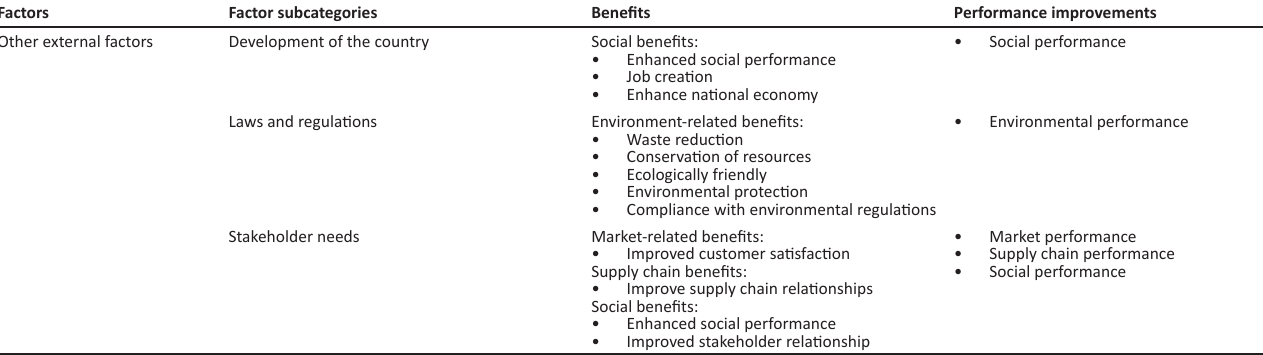
TABLE 4 (Continues...): Conceptual framework of the impact of disposition decision factors on organisational performance.